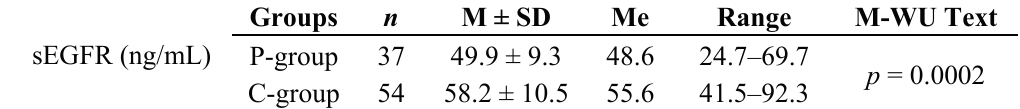
sEGFR, soluble epidermal growth factor receptor; P-Group, C-Group, healthy subjects; M ± SD (standard deviation); Me, median; n , number of samples; M-WU test, Mann-Whitney U